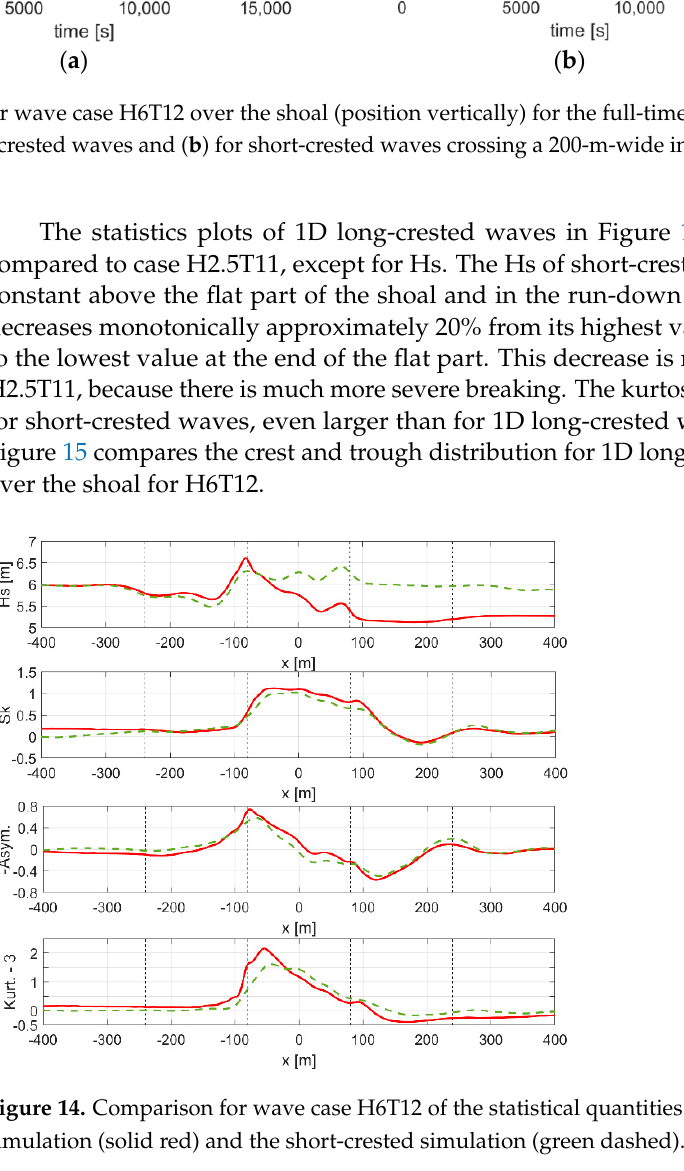
Figure 15. Crest and trough distribution over the shoal for H6T12. ( a ) for 1D long-crested waves, and ( b ) for short-crested waves, respectively.